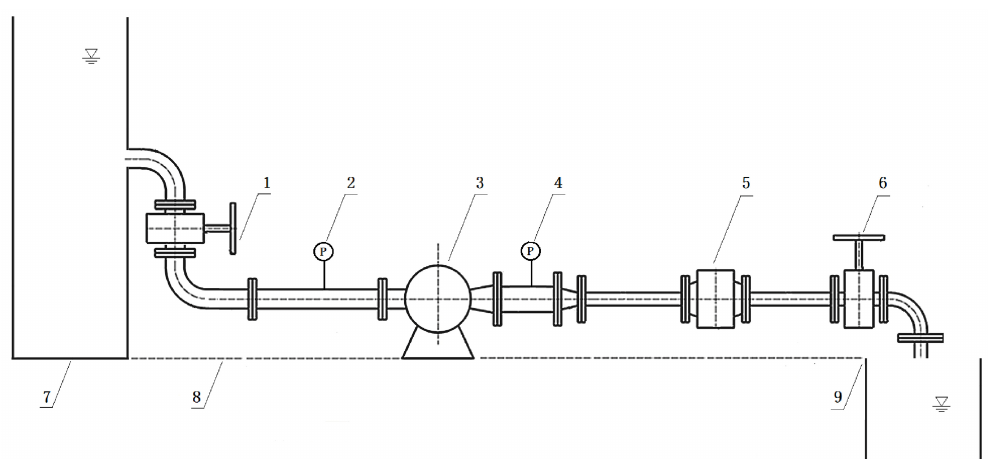
Figure 4. Schematic diagram of the test rig. 1: inlet valve; 2: vacuum gauge; 3: centrifugal pump driven by motor; 4: pressure gauge; 5: electromagnetic flowmeter; 6: outlet valve; 7: upstream tank; 8: mounting datum; 9: downstream tank.